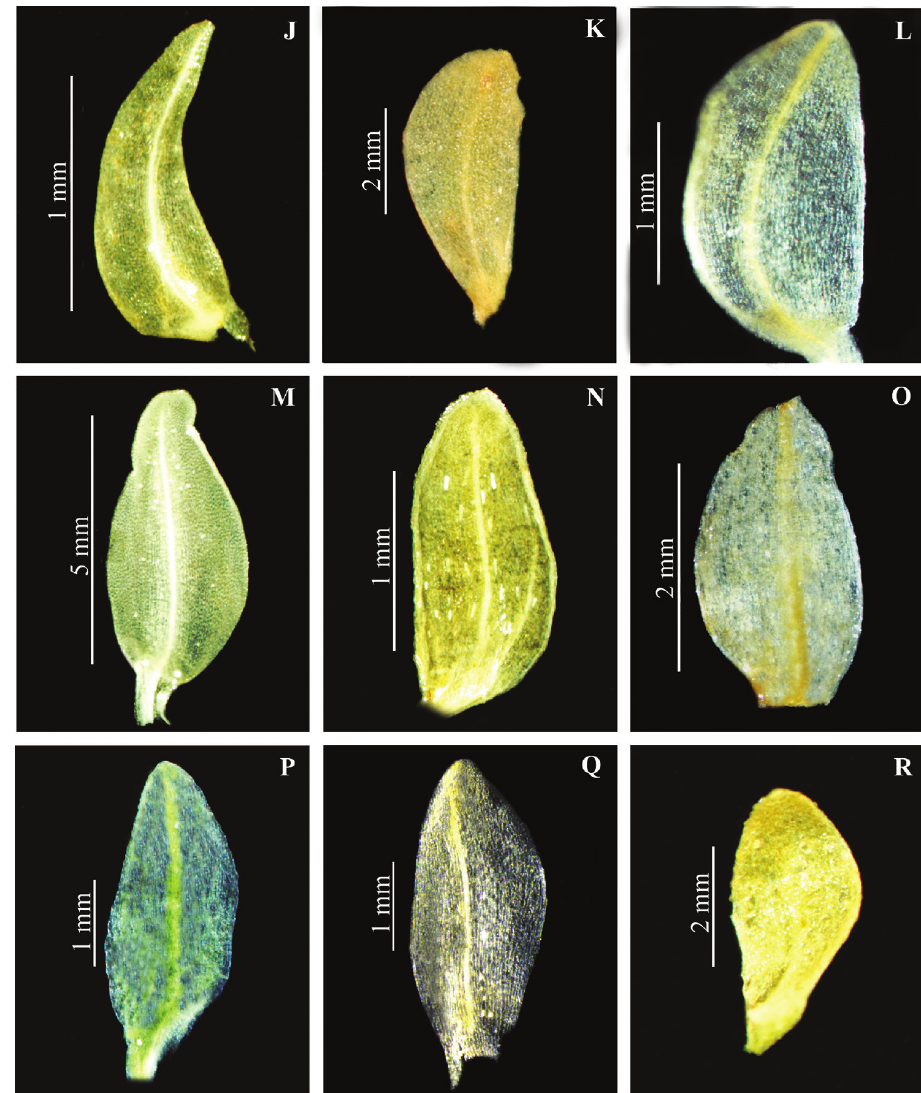
Figure 7. Continued. Lateral sepal of Herminium. J H. fallax K H. gracile L H. elisabethae M H. hima- layanum N H. clavigerum O H. quinquelobum P H. macrophyllum Q H. lanceum R H. biporosum.